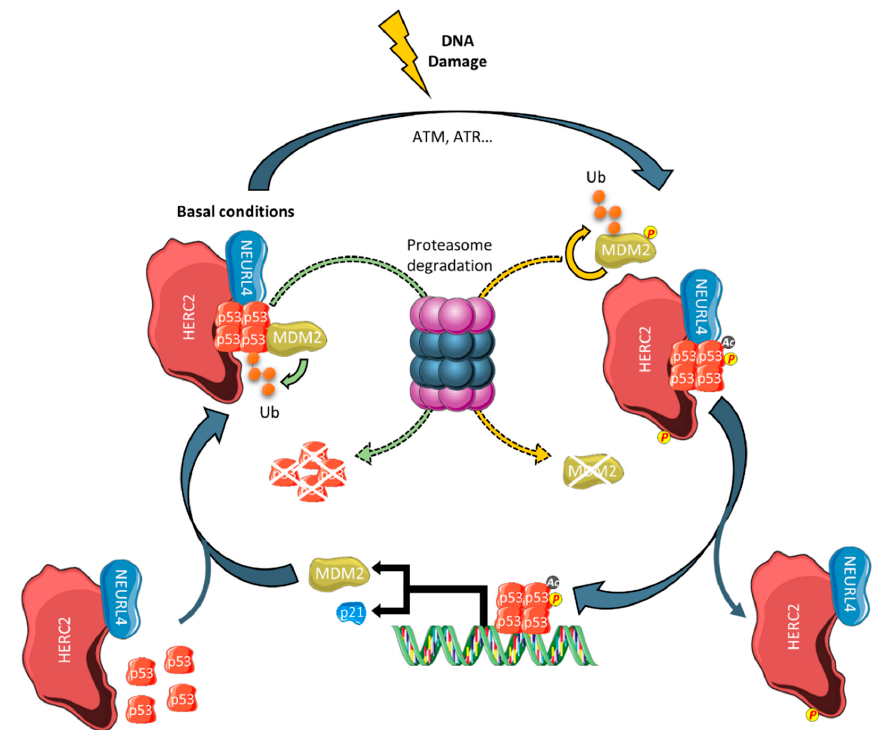
Figure 3. Regulation of the p53/MDM2 pathway by HERC2. In basal conditions, HERC2 and NEURL4 regulate p53 transcriptional activity by promoting its oligomerization. MDM2 maintains low levels of p53 by targeting it for proteasomal degradation. Upon DNA damage, associated kinases phosphorylate MDM2 and HERC2. In addition, p53 is activated by acetylation and